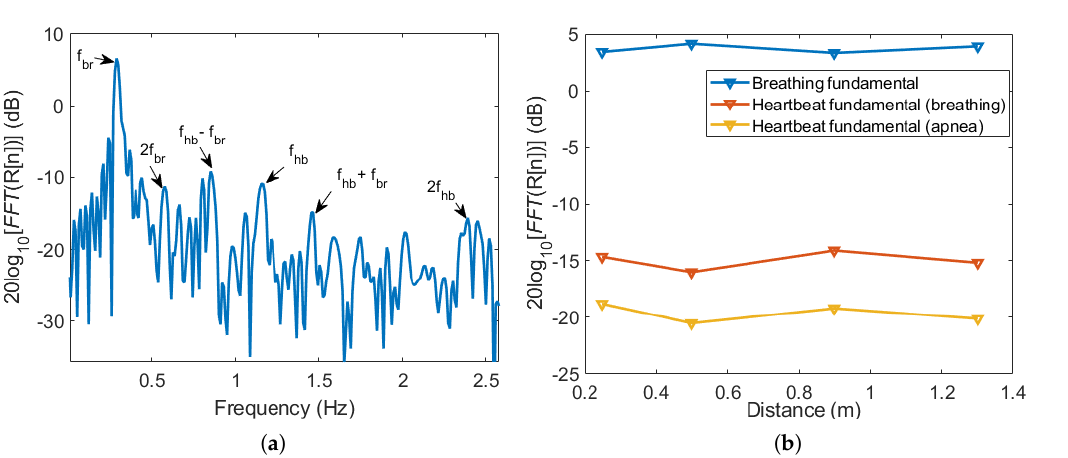
Figure 14. ( a ) Breathing and heartbeat harmonics identified in a breathing measurement spectrum. ( b ) Spectral analysis of the breathing and heartbeat fundamental components when the subject is breathing and when the subject holds his breath.